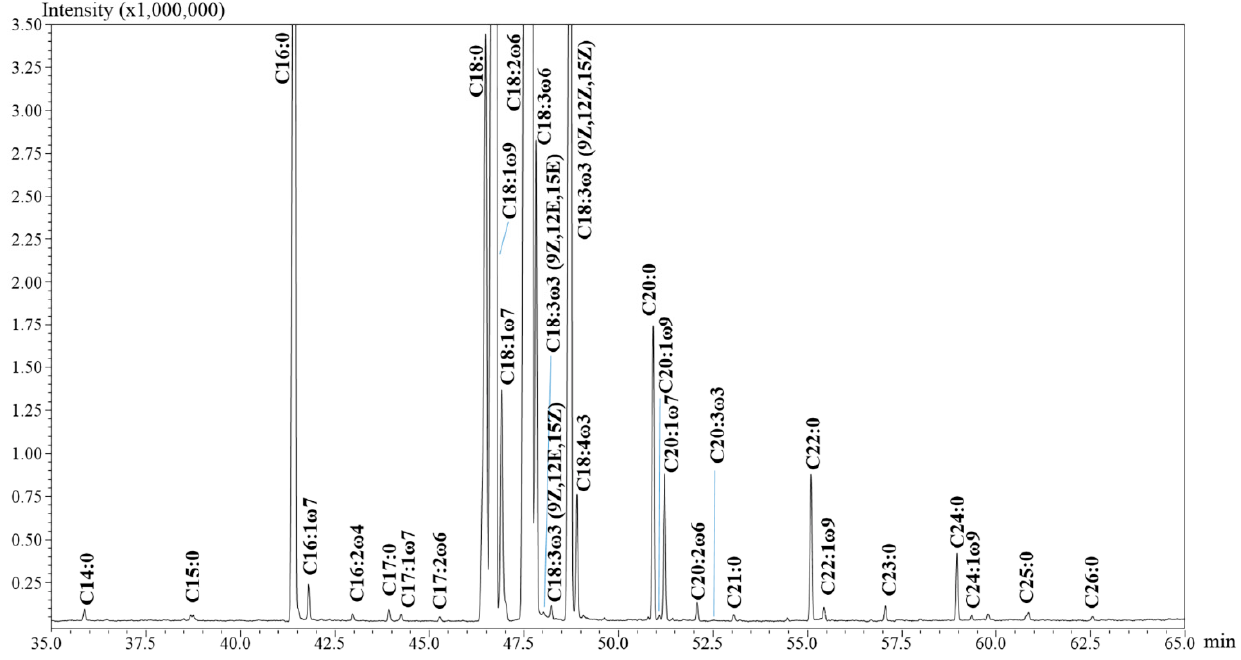
Figure 1. Thirty-minute expansion of the GC-FID chromatogram relative to the FA profile of a hempseed oil. FAs were detected as methyl esters (FAMEs).